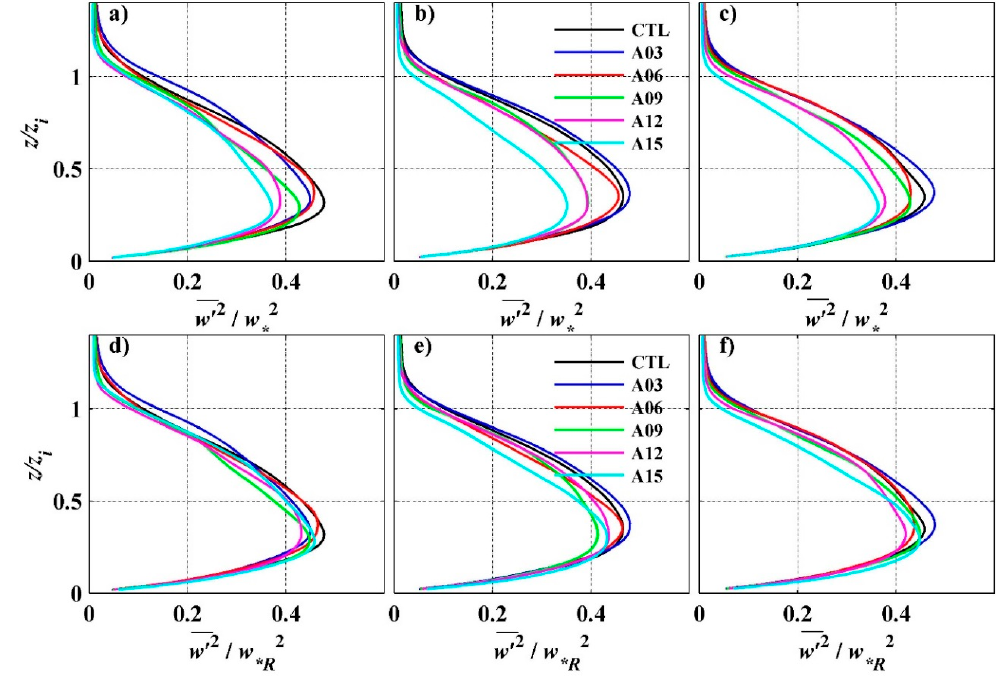
2 w ′ 2 w ′ ) normalized with ) normalized with